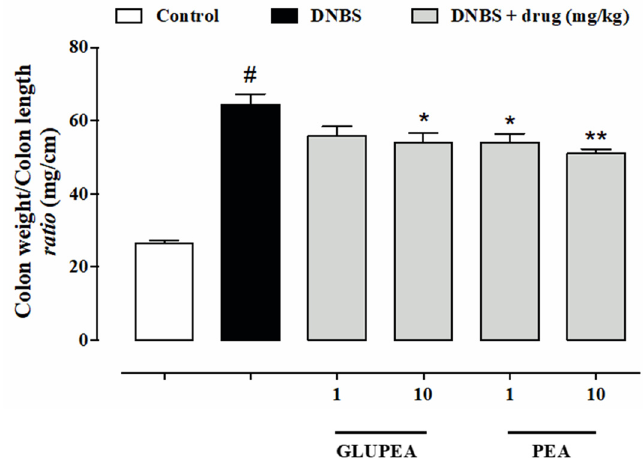
Figure 6. Effect of GLUPEA on the colon weight/colon length ratio in dinitrobenzene sulfonic acid (DNBS)-induced colitis in mice. Changes in the colon weight/colon length ratio from control and DNBS-injected mice in the presence or absence of orally administrated PEA-um (1–10 mg · kg − 1 ) or GLUPEA (1–10 mg · kg − 1 ). Mice were weighed before DNBS (or vehicle) injection and immediately before killing. Tissues were analysed 3 days after vehicle or DNBS injection. PEA-um (1–10 mg kg − 1 ) or GLUPEA (1–10 mg kg) was administered by oral gavage once a day for three consecutive days starting 24 h after the inflammatory insult. Data are the mean + s.e.m. of a single experiment, with 15 mice for each experimental group. Statistical analyses were carried out using one-way ANOVA followed by Dunnett’s multiple comparisons test ( # p < 0.0001 versus control (i.e., mice without intestinal inflammation); * p < 0.05, ** p < 0.01, versus DNBS).